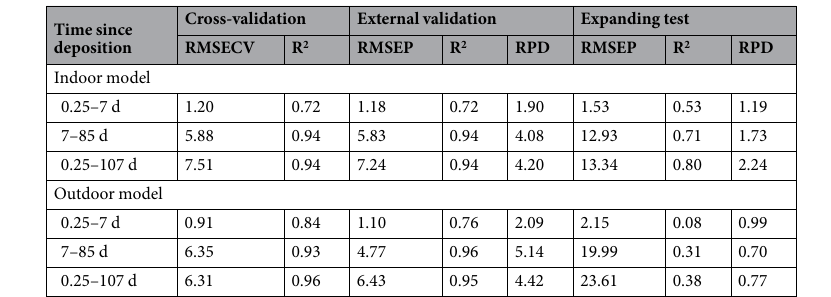
Table 3. The validation results of PLSR models in the three time